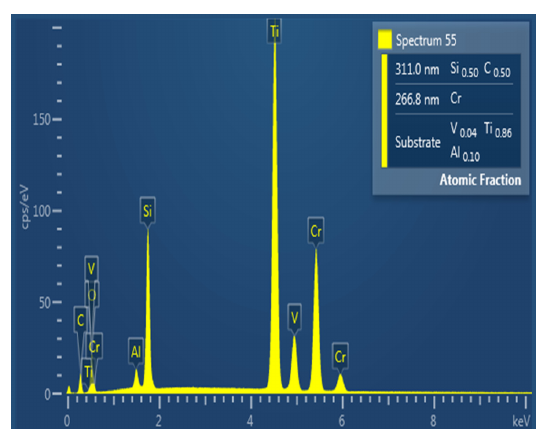
Figure 3. EDS spectra obtained with LayerProbe (sample 3).